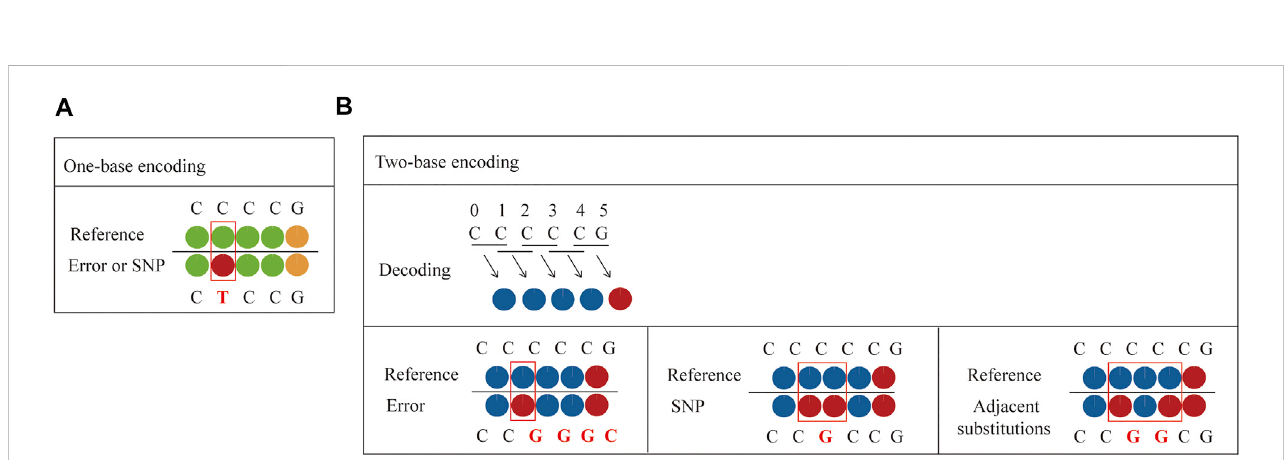
FIGURE 4 Comparison between one-base encoding and two-base encoding. (A) Characteristics ofone-base encoding. Since one color correspondsto one base, when single-color change is observed, it may be a SNP or an error. (B) Characteristics of two-base encoding. When a single-color change is observed, all bases downstream from the color change will be different from the reference sequence. It indicates an error. When SNP is present in the sequence, it affects thecolorcodes oftwoadjacent bases, resultingintwoadjacentcolorschange.When adjacent substitutionsare present inthesequence,thecolorcode corresponding to the fi rst substitution (C → G) and the previous base is different, and the color code corresponding to the second substitution (C → G) and the following base is also different, while the color code of these two substitutions can be the same or